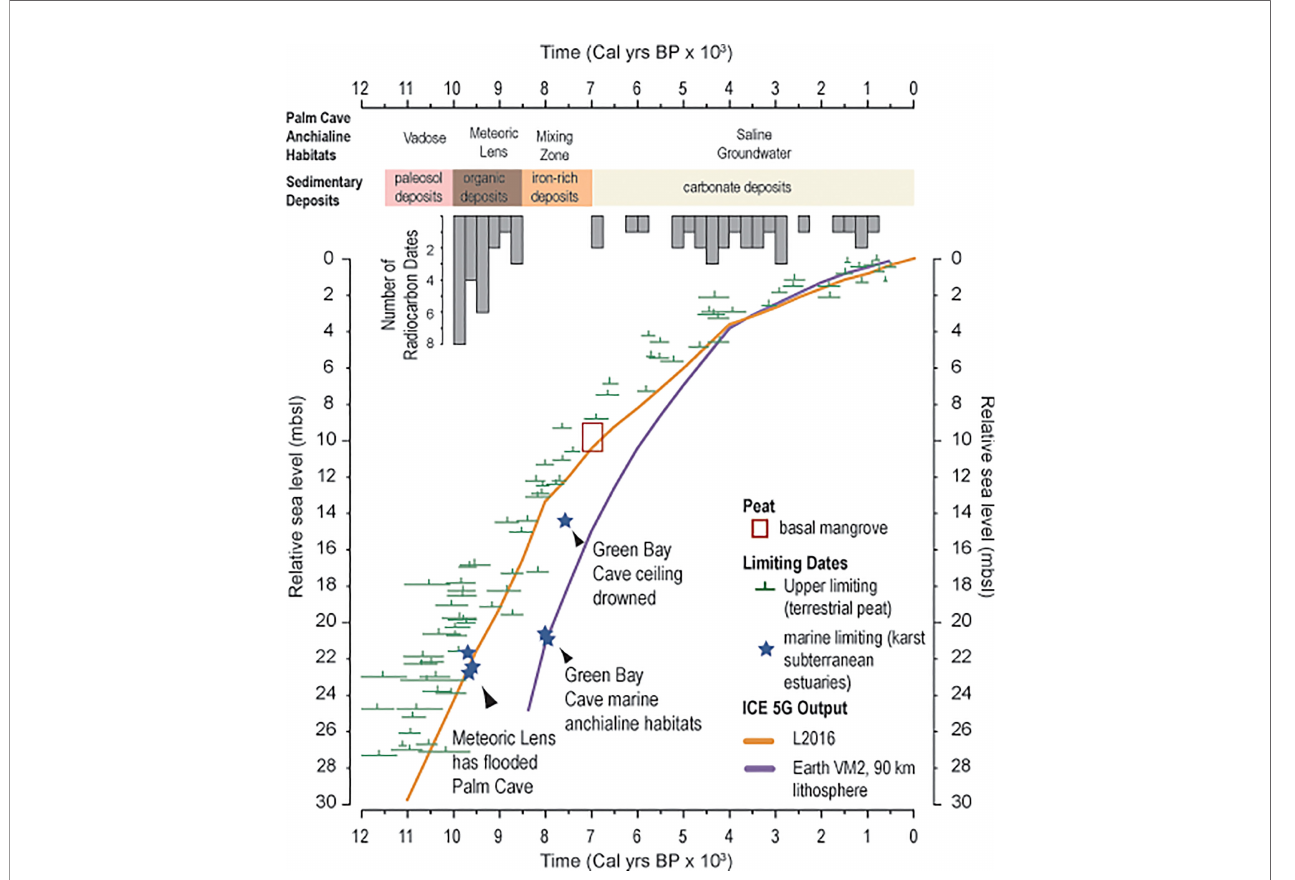
FIGURE 7 | A database of upper limiting sea level indicators from Bermuda cores is compared two glacial isostatic adjustment models, purple line is ICE-5G (Peltier, 2004) and orange line is L2016 (Love et al., 2016). The top of the meteoric lens quali fi es as a marine limiting sea level indicator, which is estimated from Palm Cave by the radiocarbon age of sediment above the limestone in the cave that contains evidence of microfossils documenting the onset of aquatic conditions of the cave. While the Palm Cave data agrees well with expectations of the position of sea level, sedimentation in Green Bay Cave was delayed by several millennia after it was initially fl ooded by a meteoric